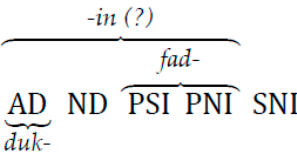
Figure 14. Reference Hierarchy for Central Asian varieties.